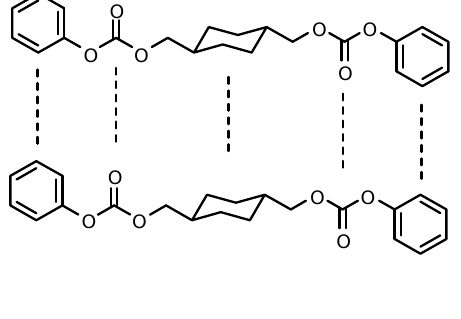
Figure 1. The structure of CHDM DPDC showing the various planar molecular sections.